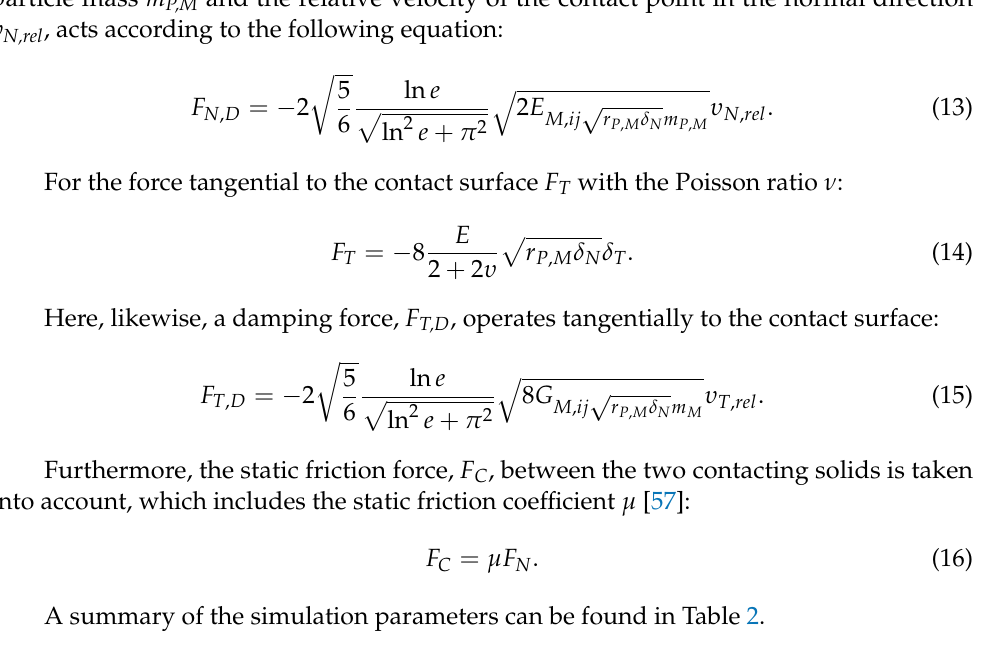
Table 2. Summary of the selected parameters in the